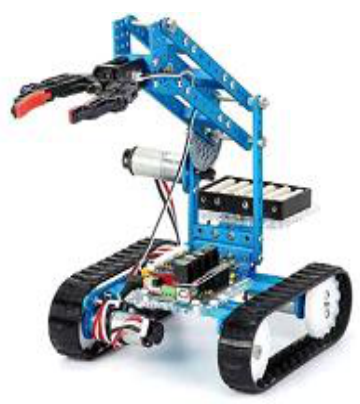
Figure 3. Drone and Robot model of the “Aprender Conectados” (Learning Connected) program (Source: Ministry of Education,